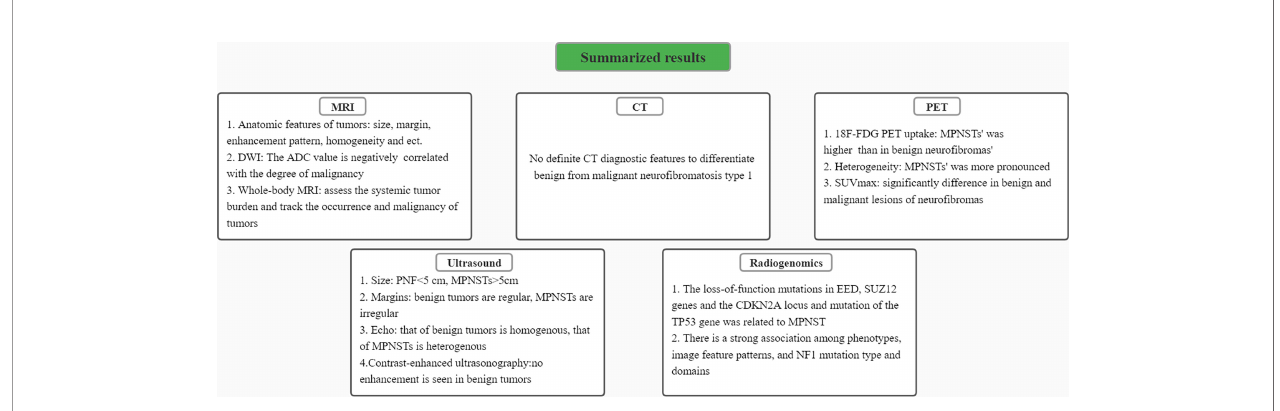
FIGURE 5 | A summary diagram of results. Characteristics of differentiating benign peripheral nerve sheath tumors from malignant ones in MRI, CT, PET, ultrasound images and radiogenomics were